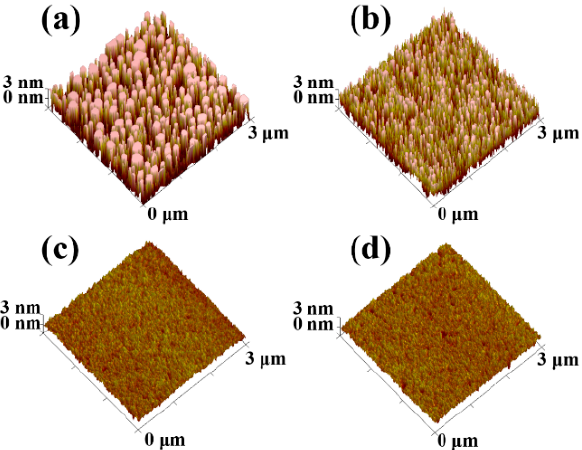
Figure 2. 3D Atomic Force Microscopy (AFM) height-profile images of gate dielectric films with increasing Ti content: ( a ) sample A, ( b ) sample B, ( c ) sample C, and ( d ) sample D.